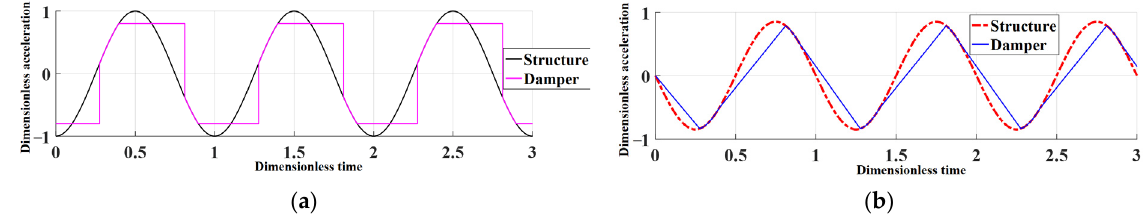
Figure 6. Motion at θ = 0° in stick–slip state ( k = 0.8): ( a ) Acceleration; ( b ) Velocity.